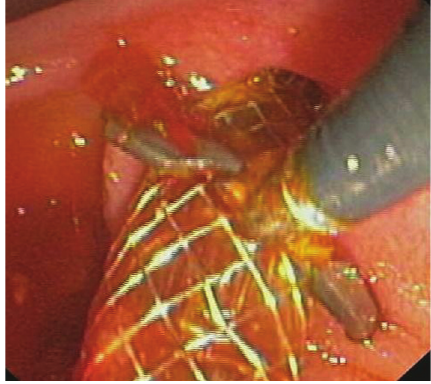
Figure 9: The metal stent is removed with alligator-tooth forceps.